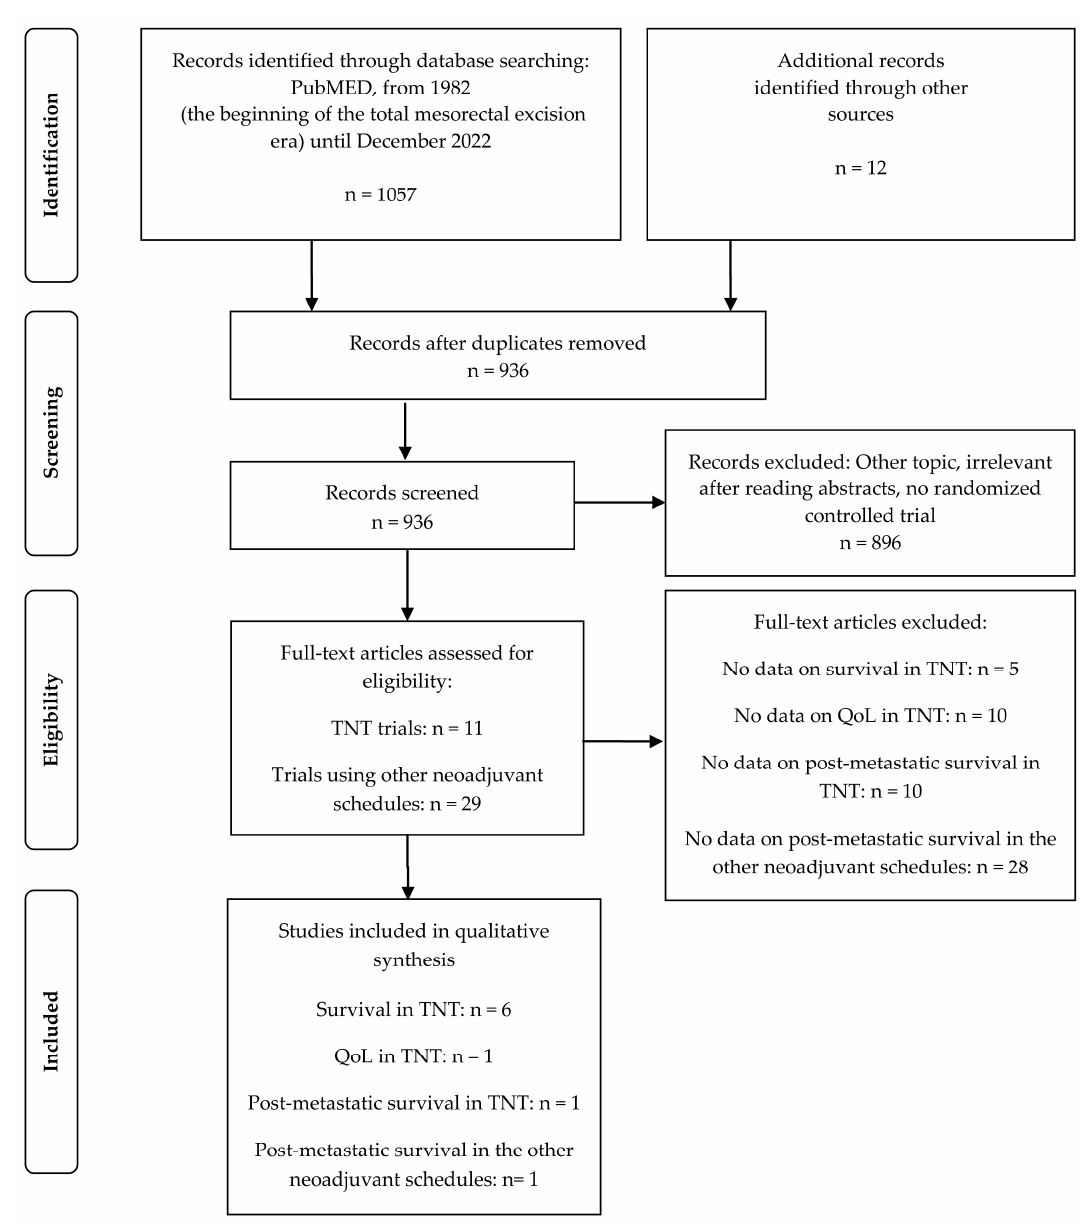
Figure 1. Flow diagram of study retrieval for the systematic review.